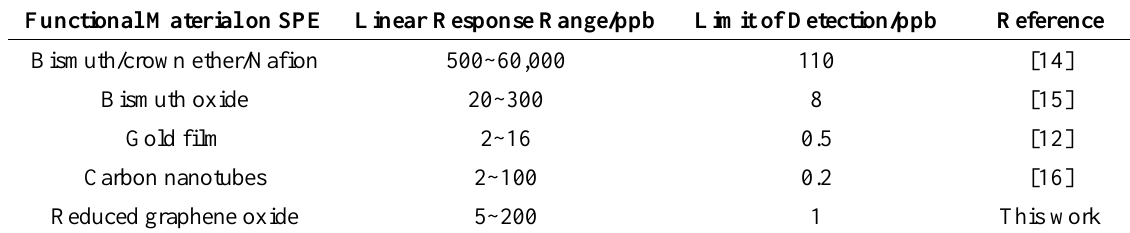
Table 2. The Pb 2+ detection performance of the as-prepared sensor, compared with the